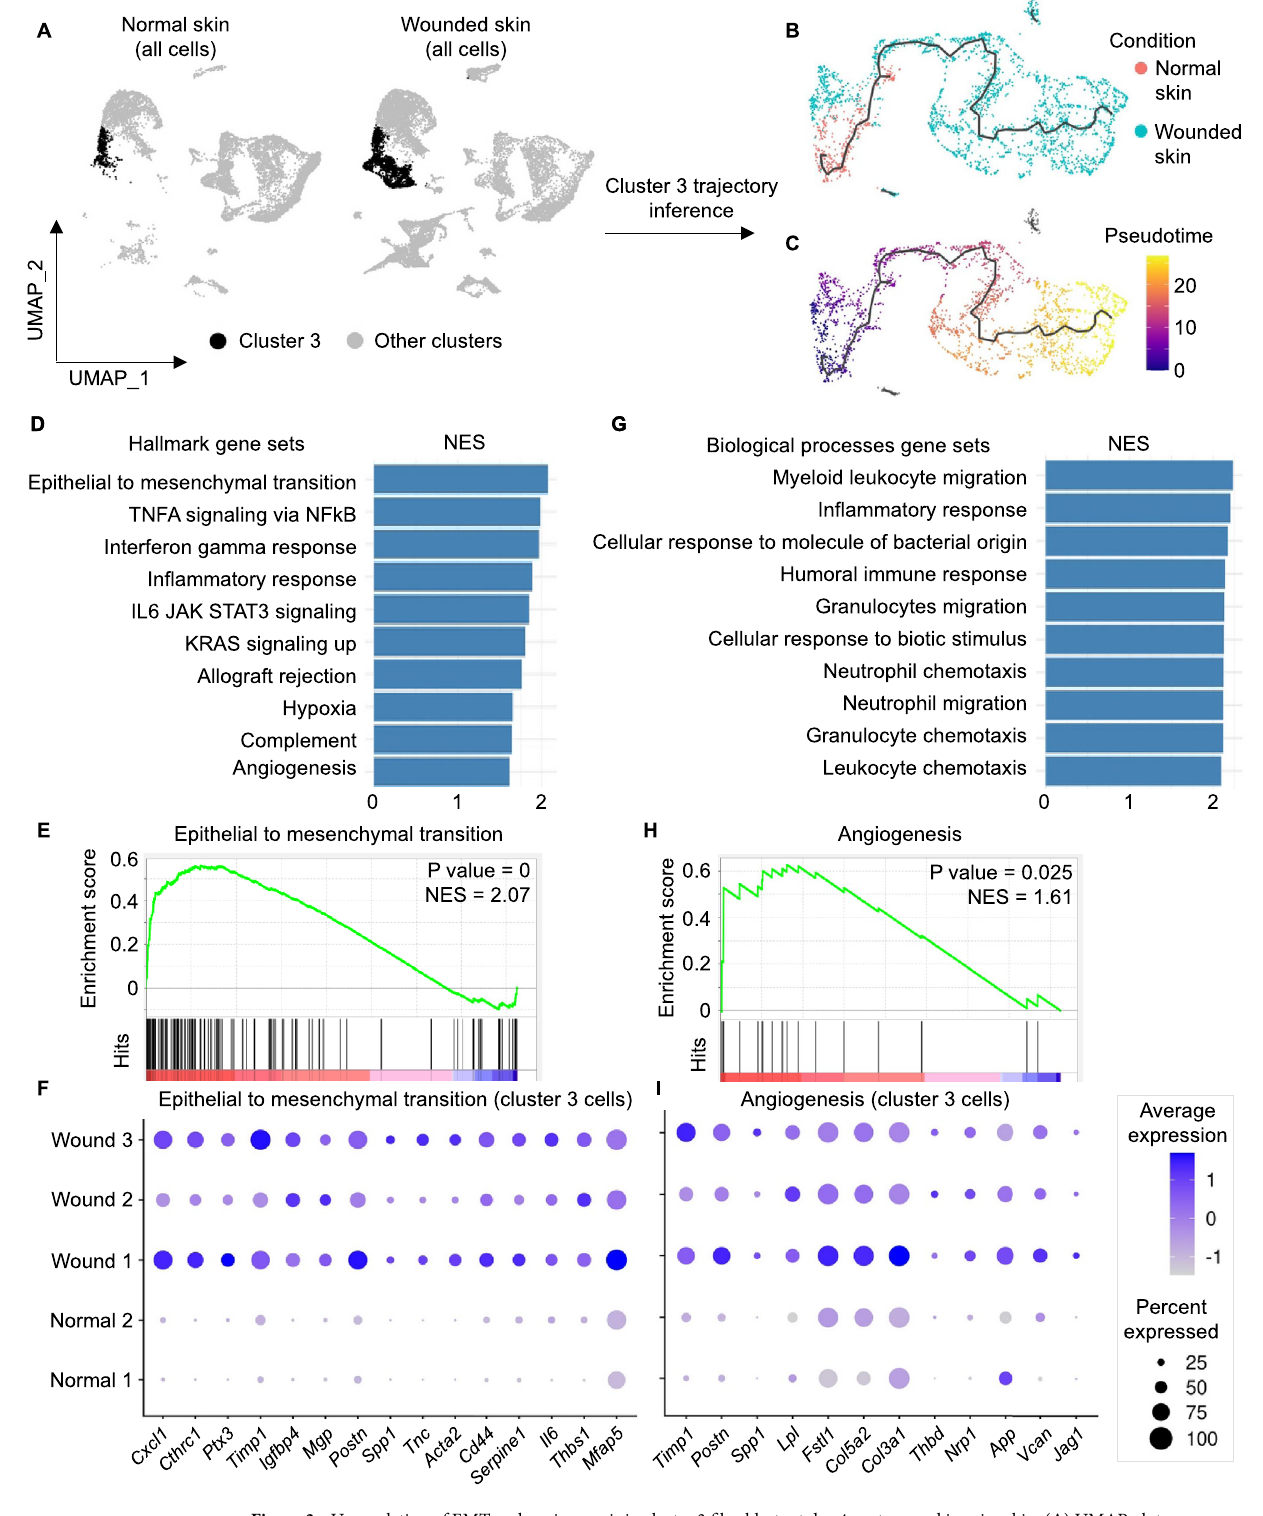
Figure 3. Upregulation of EMT and angiogenesis in cluster 3 fibroblasts at day 4 post-wound in mice skin. ( A ) UMAP plot representing cluster 3 in a black color and other clusters in s grey color. ( B , C ) UMAP plots of cluster 3 cells colored by condition and pseudotime receptively. The black line represents the inferred trajectory. ( D , G ) Top 10 uppregulated hallmark and biological processes gene sets in cluster 3 in wounded skin compared to normal skin. Bars represent the normalized enrichment score (NES) of the gene set enrichment analysis. ( E , H ) GSEA enrichment plot for EMT and angiogenesis. Hits (black lines) represent the intersection between the DEGs and the enriched gene sets. ( F , I ) Dotplots representing relative expression level of the top upregulated genes having role in EMT and angiogenesis respectively with log2FC > 0.25 in cluster 3 during wound healing compared to cluster 3 in normal skin. Dot size represents percentage of cells within cluster 3 expressing the gene in each sample. Dot color represents the relative expression level of the